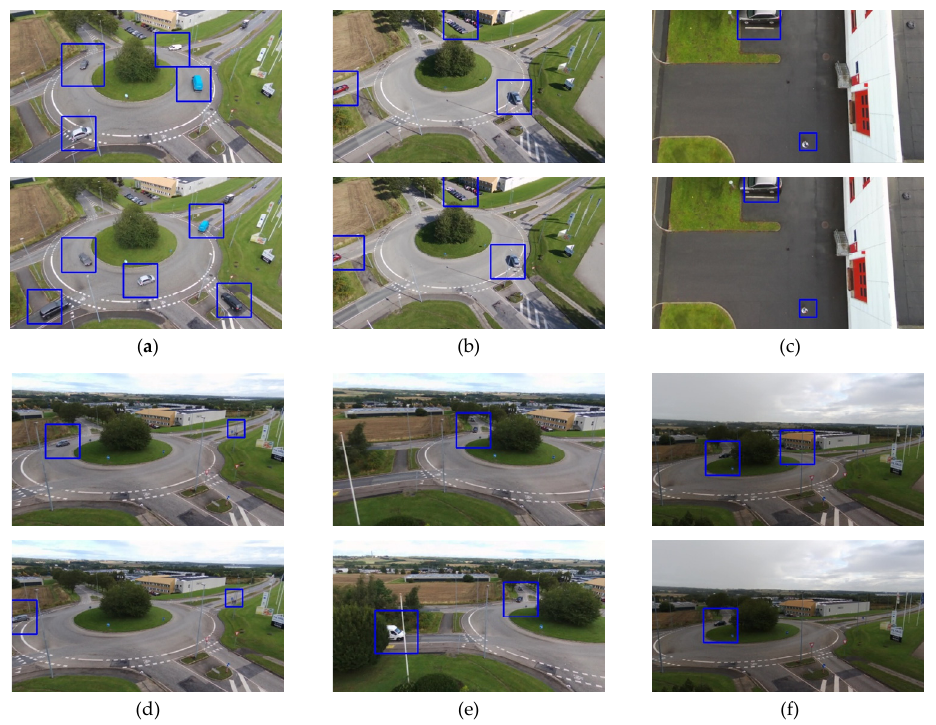
Figure 6. The location result of OTNet in different scenes. ( a ) Multi-objects. ( b ) Truncation. ( c ) Bird view. ( d ) Tiny objects. ( e ) Occlusion. ( f ) Low contrast.